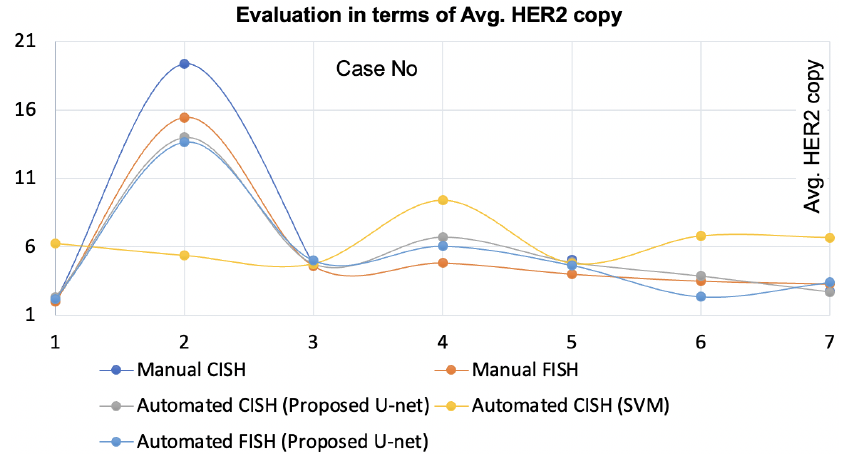
Figure 13. Evaluation of proposed nuclei segmentation-enabled automatic HER2 quantification using both CISH and FISH with respect to the average HER2 copy.